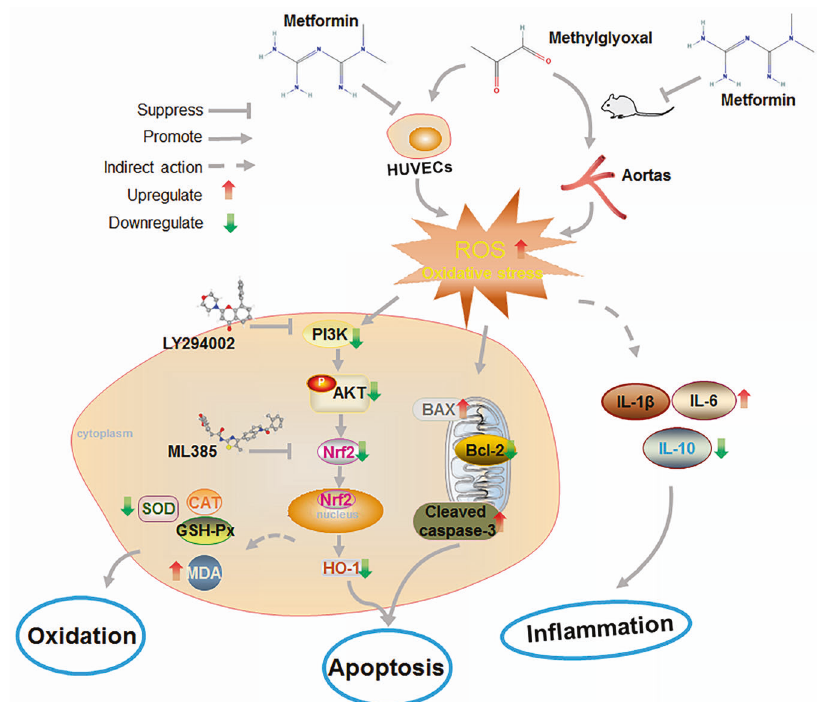
Fig. 7 Schematic diagram showing the cytoprotective signaling associated with MET in MGO-induced endothelial cell apoptosis. The possible molecular mechanisms of MET in MGO-induced endothelial dysfunction in human ECs were explored. As depicted, MET inhibited the apoptotic signaling cascades initiated by MGO-generated ROS via modulating the PI3K/Akt and Nrf2/HO-1 signaling pathways. Furthermore, MET effectively exerts protective effects against MGO-induced oxidative stress, mitochondrial dysfunction, apoptosis, and in fl ammation in vitro and in